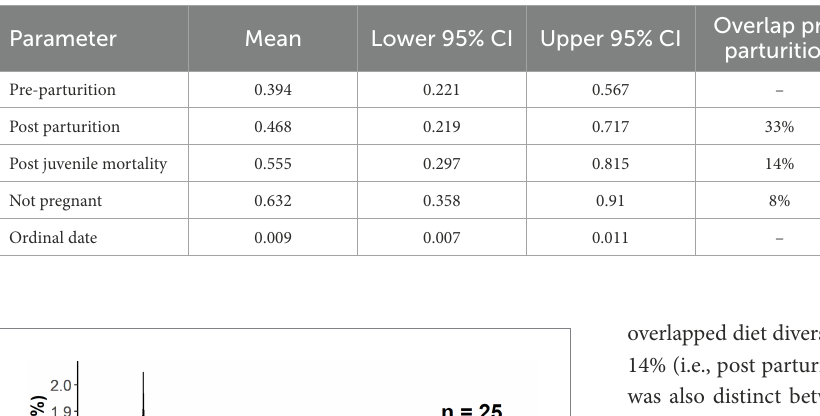
TABLE 2 Results from the ANCOVA in a Bayesian hierarchical framework testing the effect of Ordinal date and parturition groups (i.e., Pre- parturition, post parturition, post juvenile mortality, and not pregnant) on the percent of fecal nitrogen in the diets of desert bighorn sheep at Lone Mountain, Nevada (2016–2018).